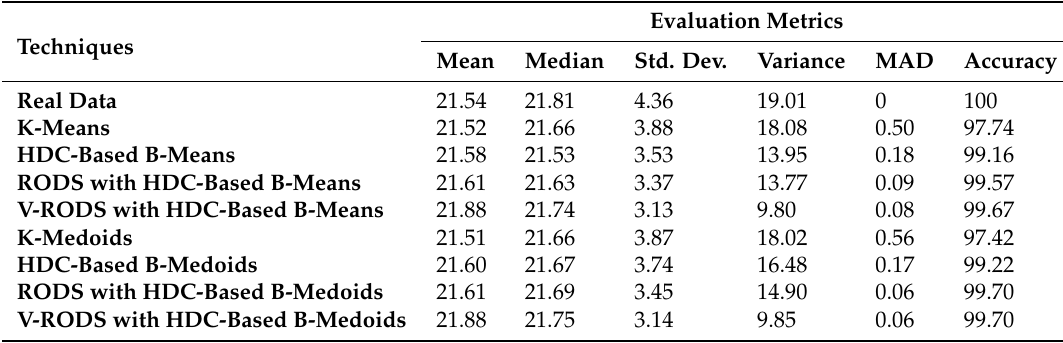
Table 2. A comparison table of average values of all segments collected from C1 based on